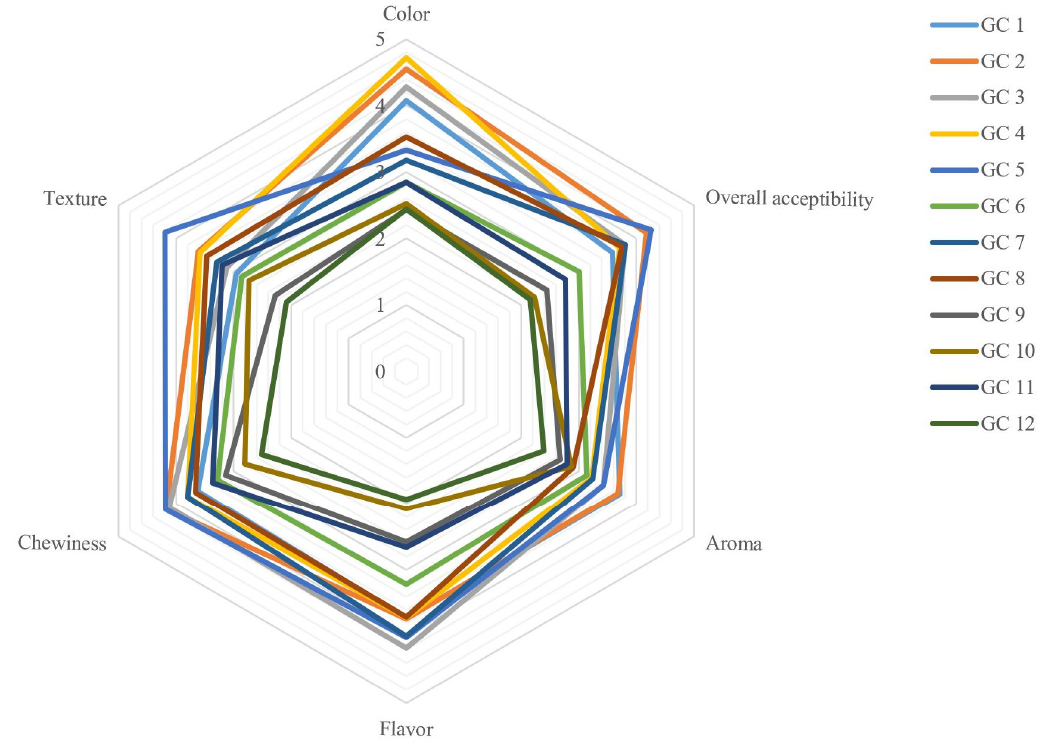
Figure 1. Sensory properties of different GCs.